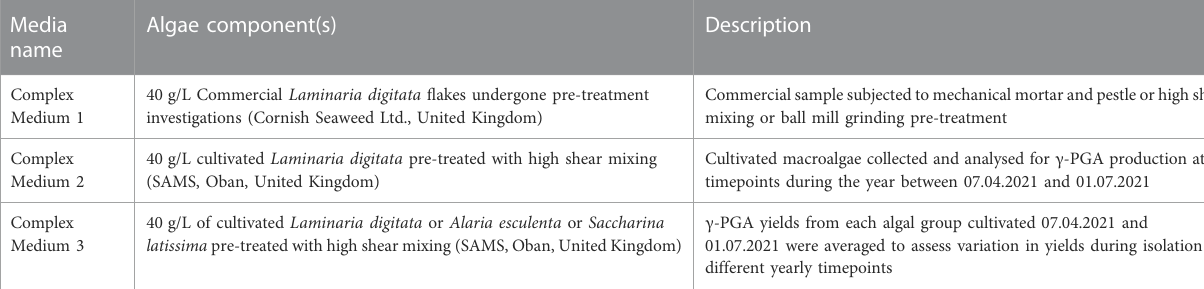
TABLE 1 Summary of complex algae media, their pre-treatment and fi gures which display their average yields in γ